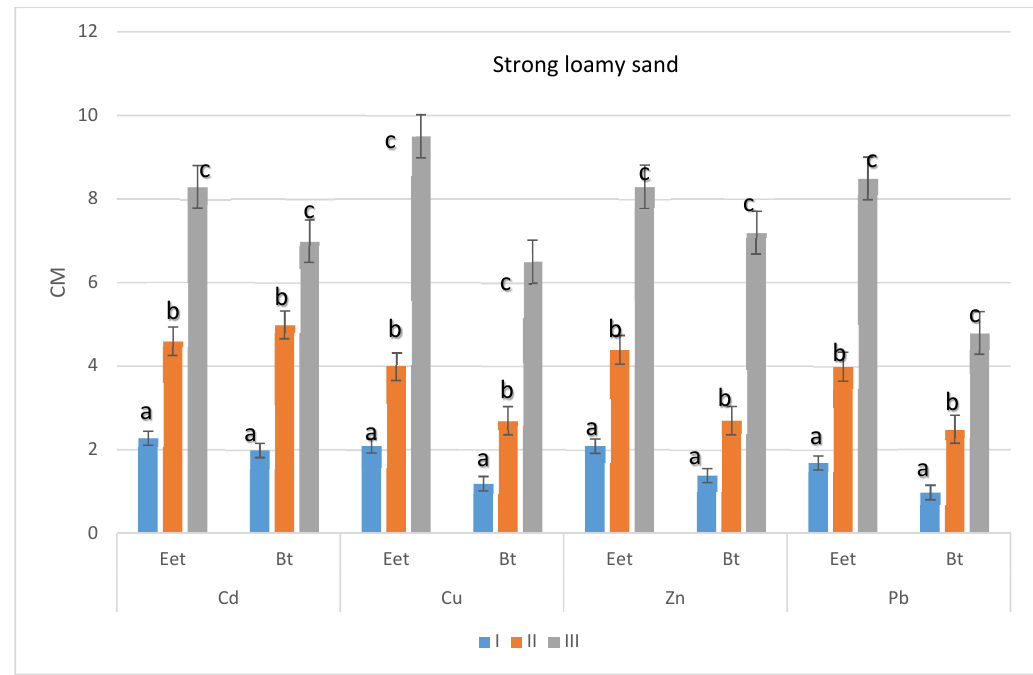
Figure 4. The mobility coefficients (CM) for Cd, Cu, Zn and Pb determined in HCl (1 mol dm − 3 ) in Et and Bt levels in light soil depending on the degree of contamination of the soils with these elements. a,b,c—treatments with the same letter are not significantly different ( p ≤ 0.05), Et—the subsurface horizon of eluvial loss of silt and clay, Bt—the subsurface horizon of illuvial accumulation of clay and humic substances.